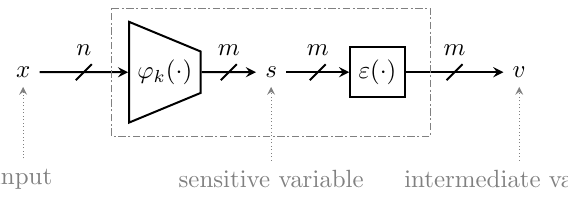
Figure 1: An illustration of how a sensitive intermediate variable is